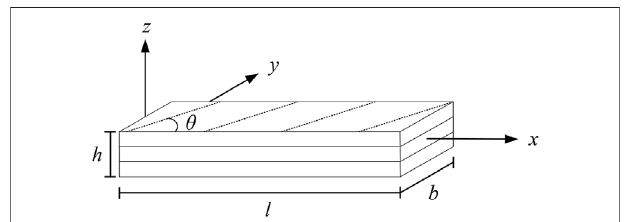
FIGURE 1 | Geometry of a cross-ply laminated composite